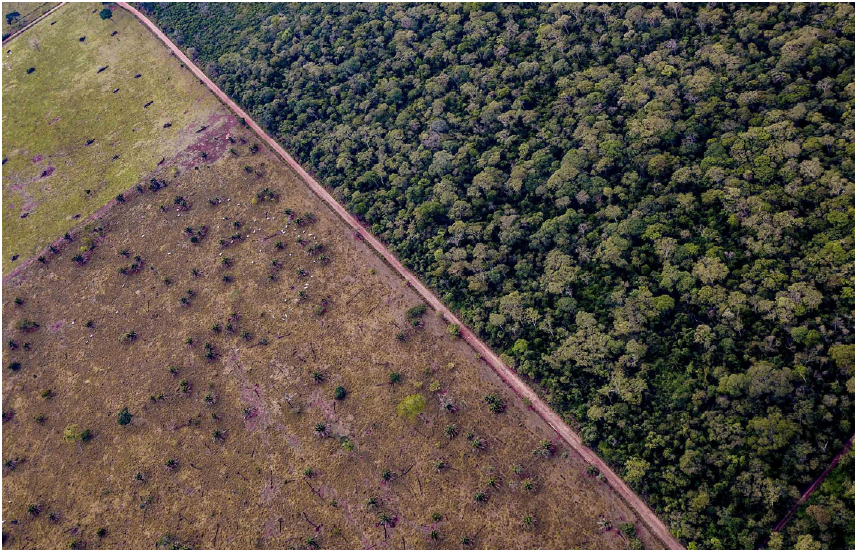
Figure 1. The Chiquitano Dry Forest, one of the ecoregions with the highest rates of deforestation in Bolivia. Photo: Daniel Coimbra.